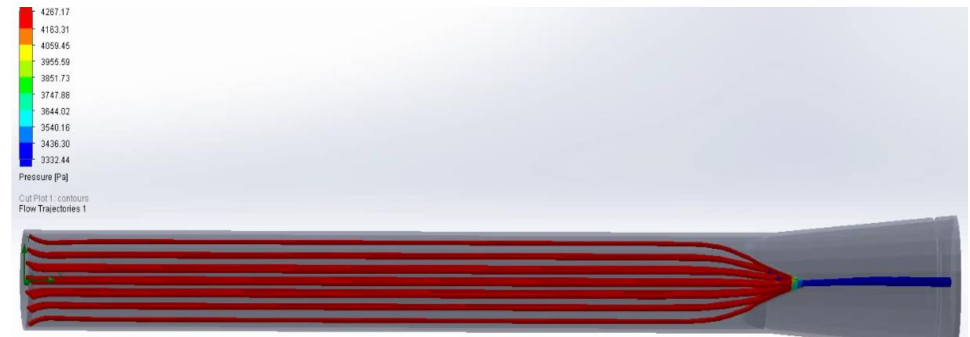
Figure 15. Computer simulation analysis of fluid with pressure of 32 mmHg to 25 mmHg (2020).